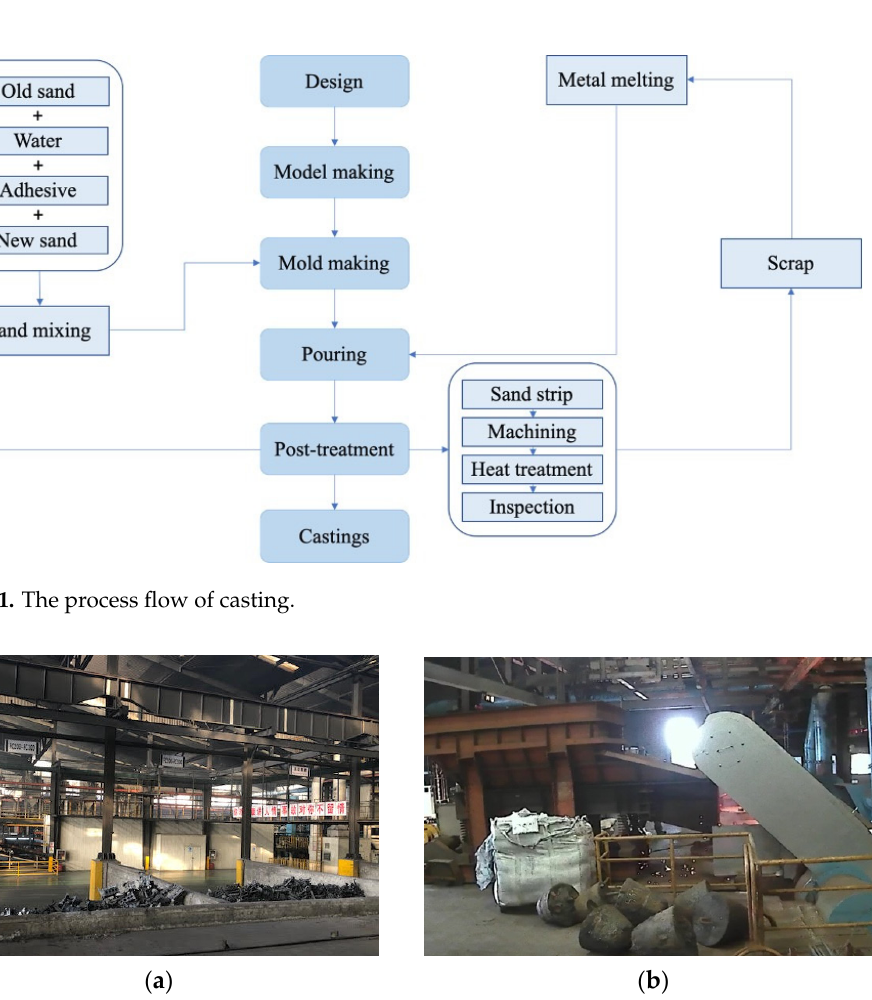
Figure 2. ( a ) The scene in the preparation area. ( b ) The process of feeding materials into the furnace.